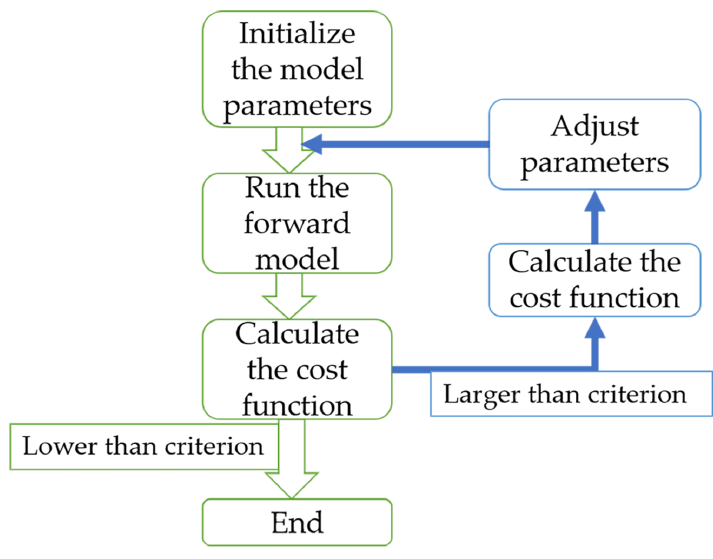
Figure 2. Flowchart of the parameter optimization.